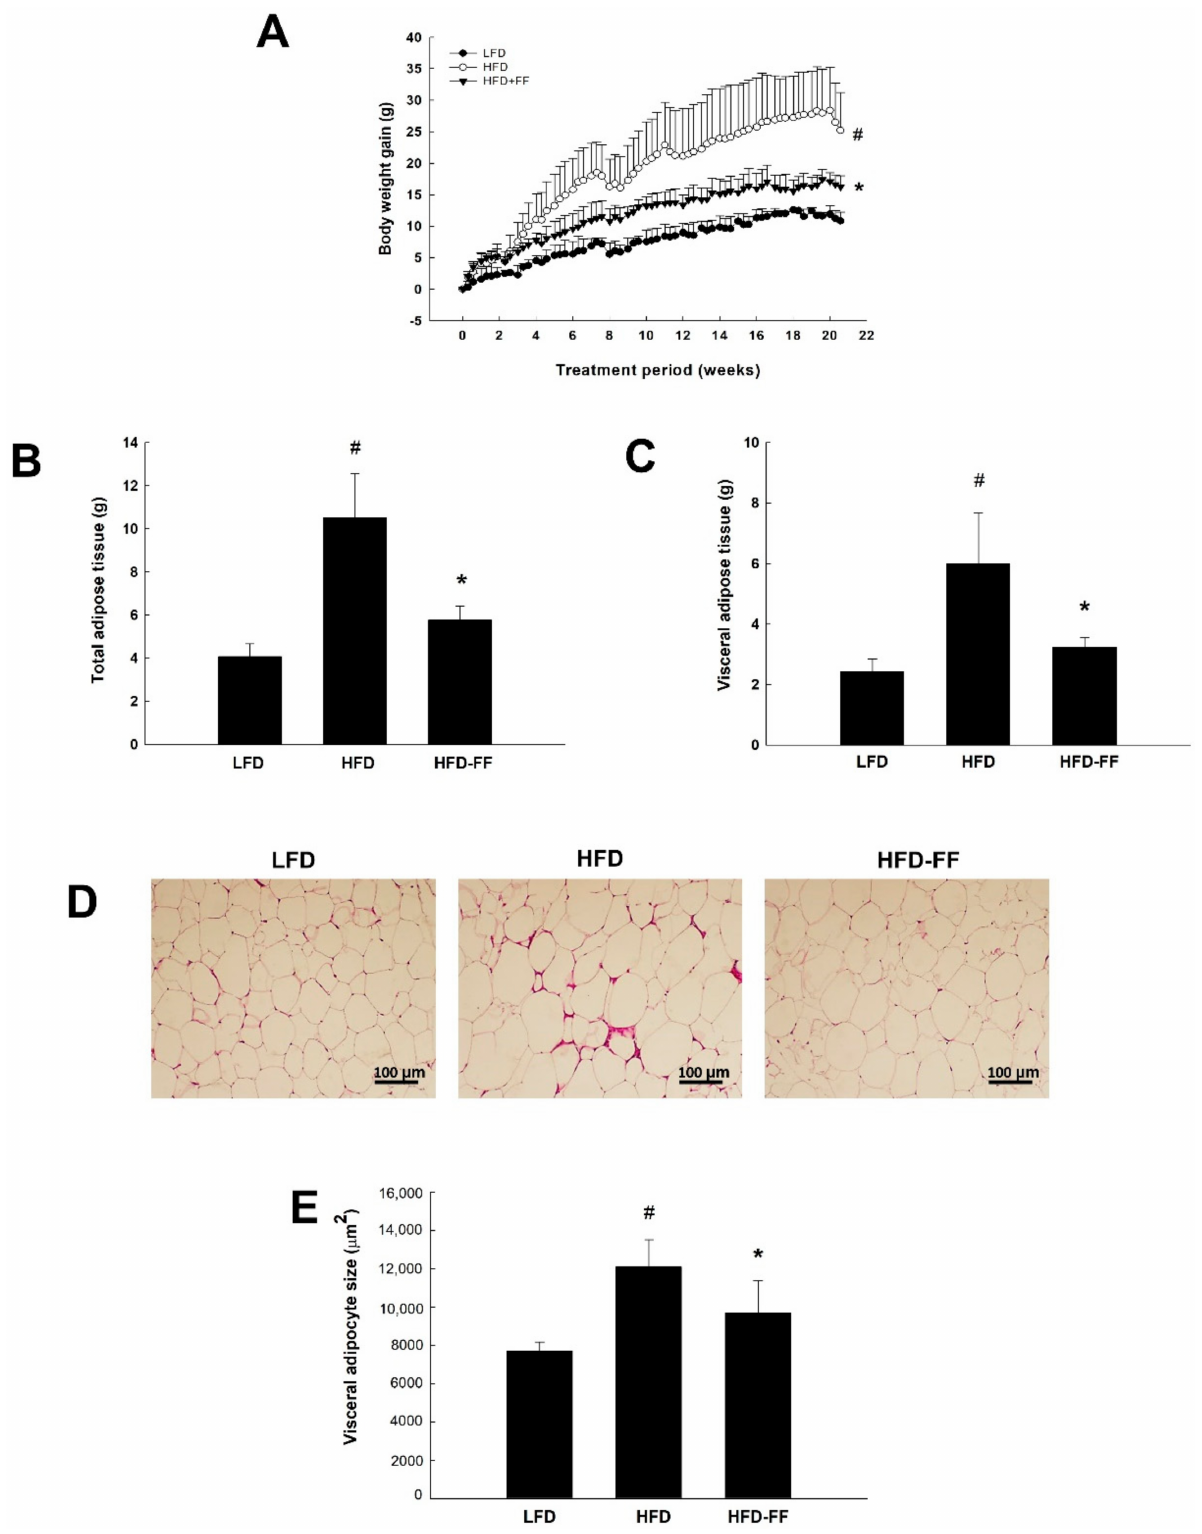
Figure 1. Effects of fenofibrate on body weight gain, adipose tissue mass, and visceral adipocyte size in HFD-fed female OVX mice. OVX C57BL/6J mice were fed an LFD, an HFD or an HFD supplemented with fenofibrate (HFD-FF, 0.05% w / w ) for 21 weeks. ( A ) Body weight gains at the end of the treatment period are significantly different. ( B ) Total and ( C ) visceral adipose tissue mass. ( D ) Histology of visceral adipose tissue. Hematoxylin-eosin-stained visceral adipose tissue sections (original magnification × 100). ( E ) Visceral adipocyte size. All values are expressed as the mean ± SD ( n = 8/group). # p < 0.05 compared with LFD. * p < 0.05 compared with